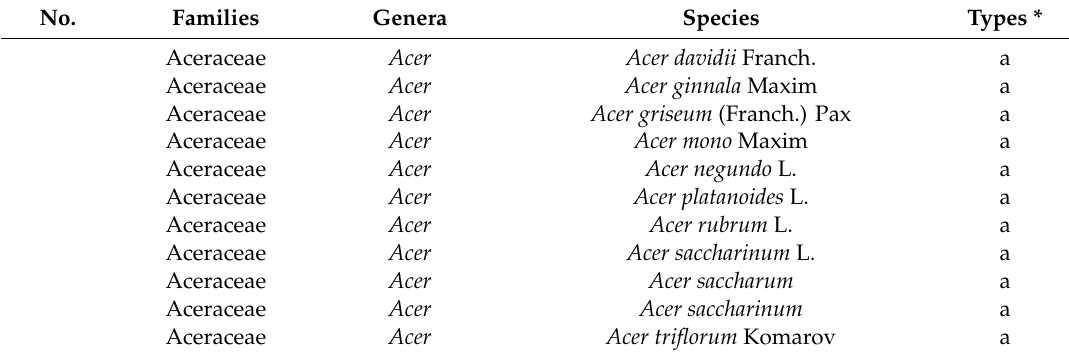
Table 1. Plant species planted in Xiongan New